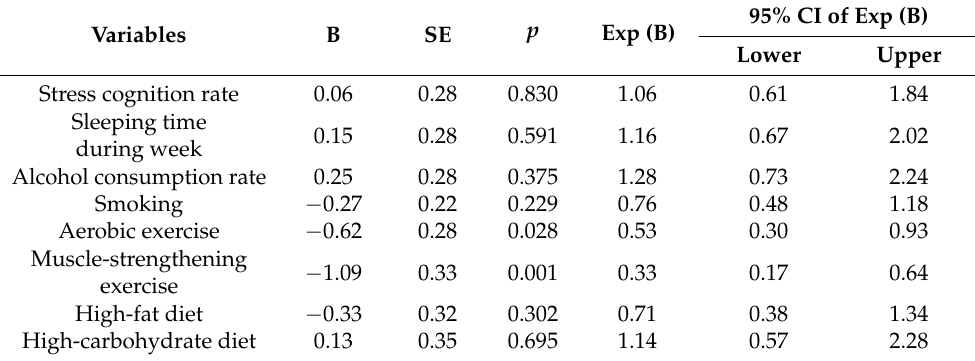
Table 3. Obesity-associated factors in adult women who experienced early